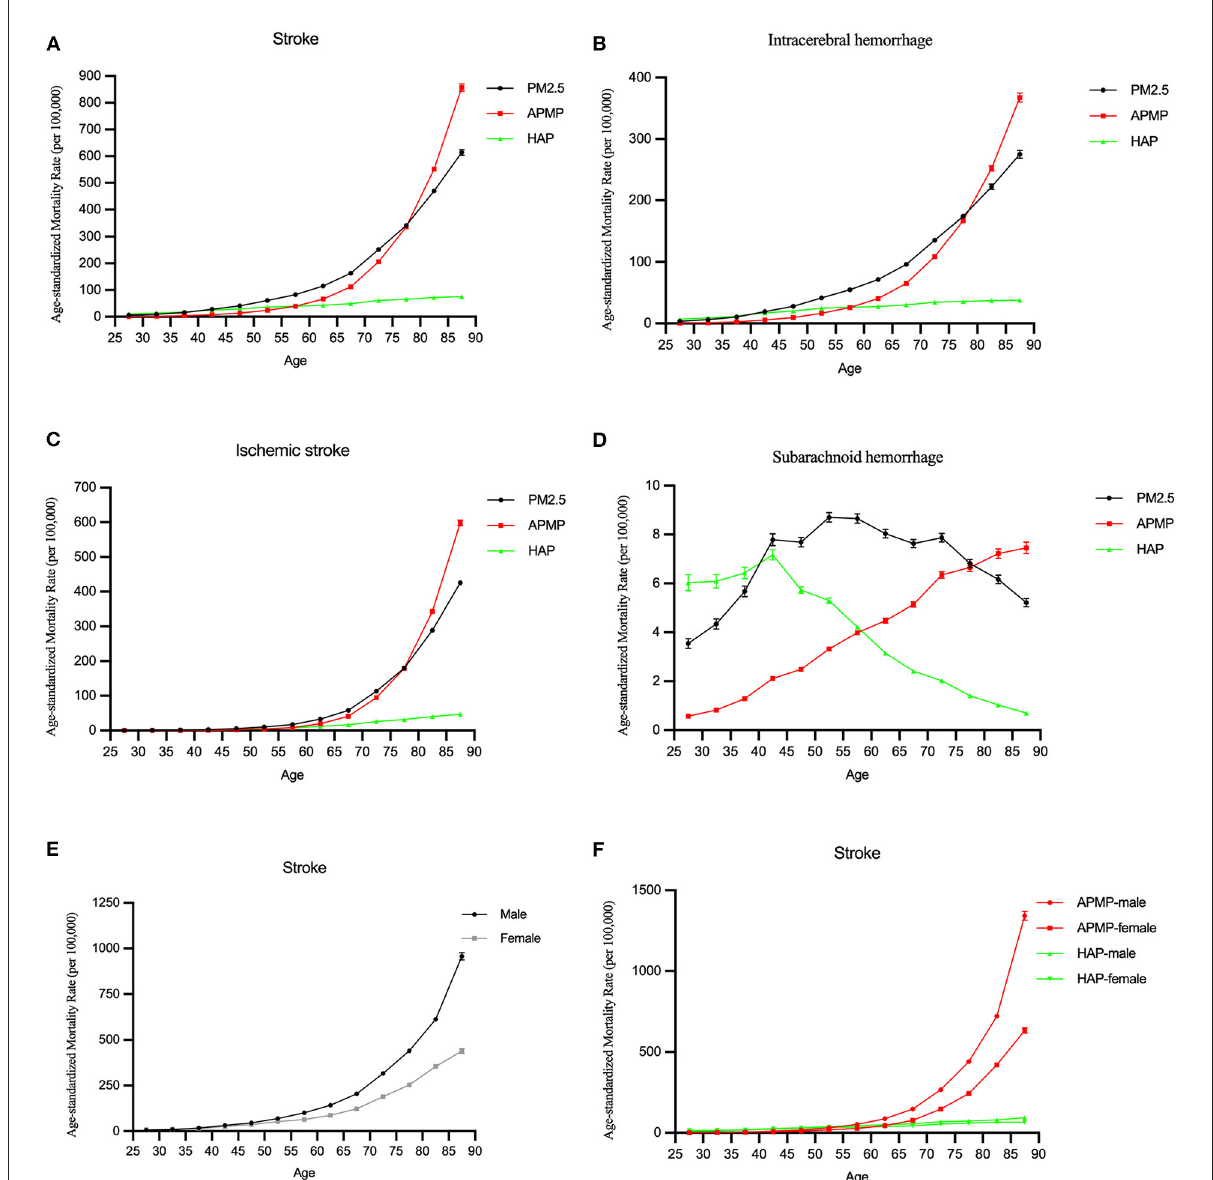
FIGURE2 The longitudinal age curves of the mortality rate of stroke attributable to PM2.5 exposure from 1990 to 2019. (A–D) The longitudinal age curves of stroke and subtypes for both sexes in PM2.5 exposure. (E) The longitudinal age curves of stroke by sex in PM2.5 exposure. (F) The longitudinal age curves of stroke by sex in ambient particulate matter pollution (APMP) and household air pollution (HAP).